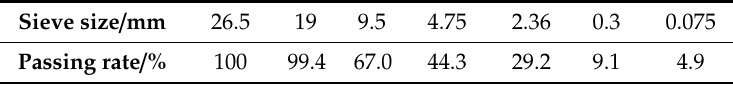
Table 3. Passing rate of the key sieve for the design